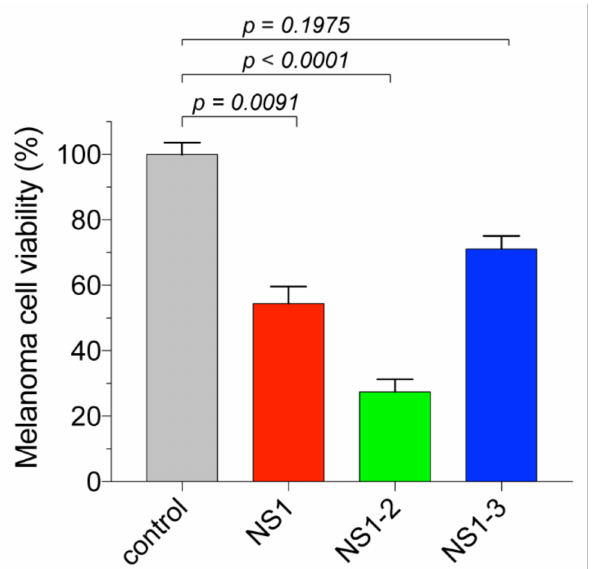
Figure 4. Effects of 30 µ M NS1 (as a 40:60 mixture of isomers) and NS1-2 and NS1-3 on A375 melanoma cells viability after 48 h of culture. Representative data of 3 experiments in triplicate. The mean values of 5 experiments at 72 h are the following: NS1: 69 ± 4%, NS1-2: 59 ± 7%, NS1-3: 66 ± 11% (data not